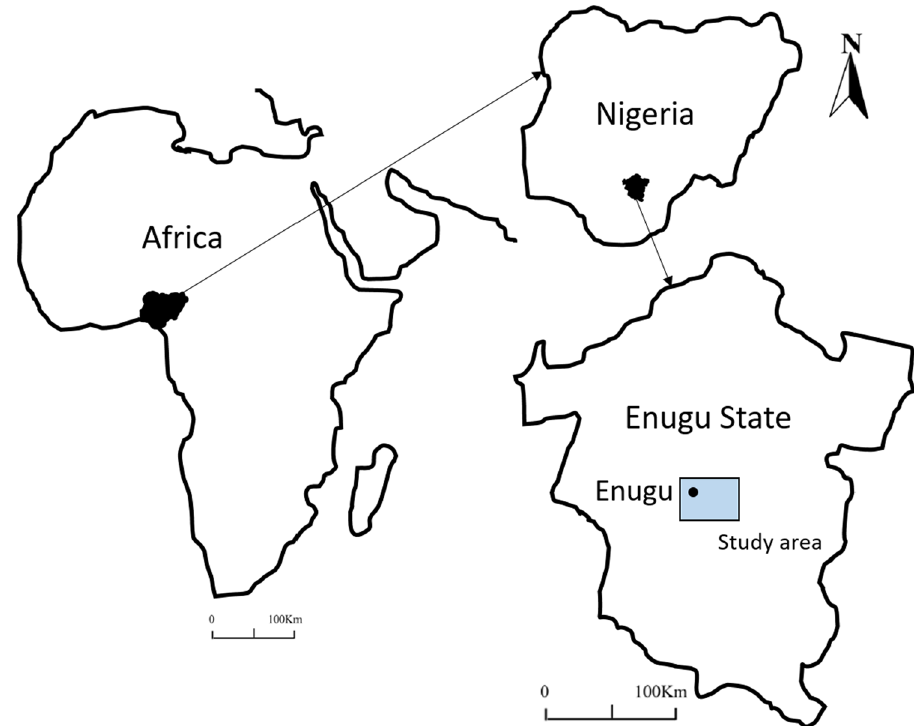
Fig. 1 Map of showing the loca- tion of Enugu